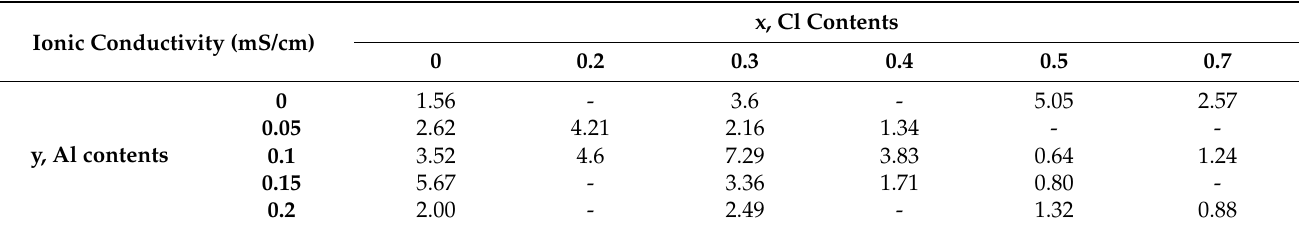
Table 1. Ionic conductivity of Li 6 − x − 3y Al y PS 5 − x Cl 1+x (0 ≤ x ≤ 0.2, 0 ≤ y ≤ 0.7) electrolytes as a function of Cl and Al